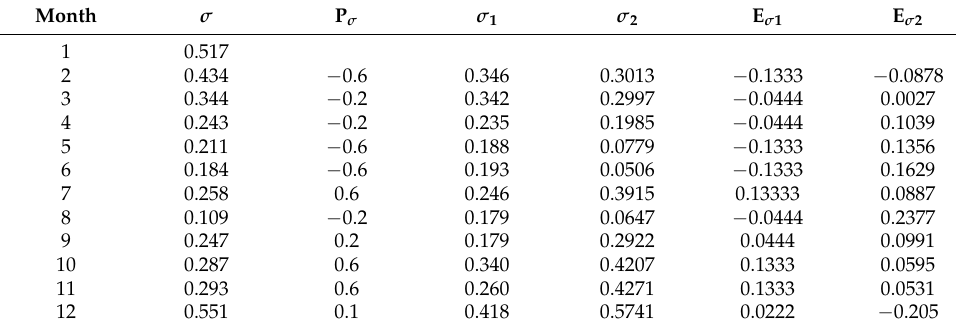
Table 10. Monthly forecasting error of σ parameter.